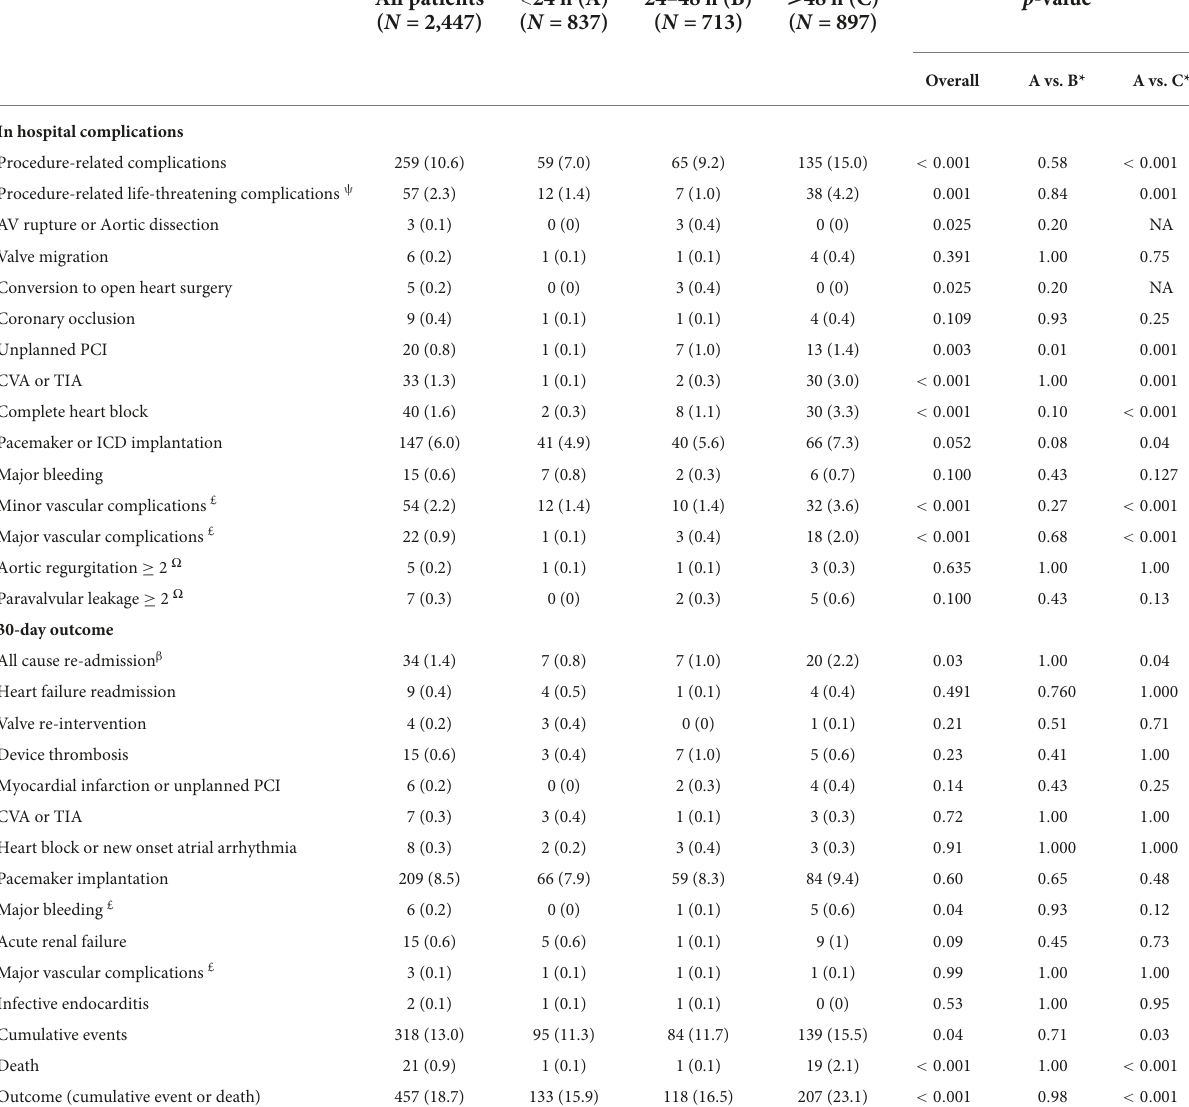
TABLE 2 Procedure related outcome stratified by discharge